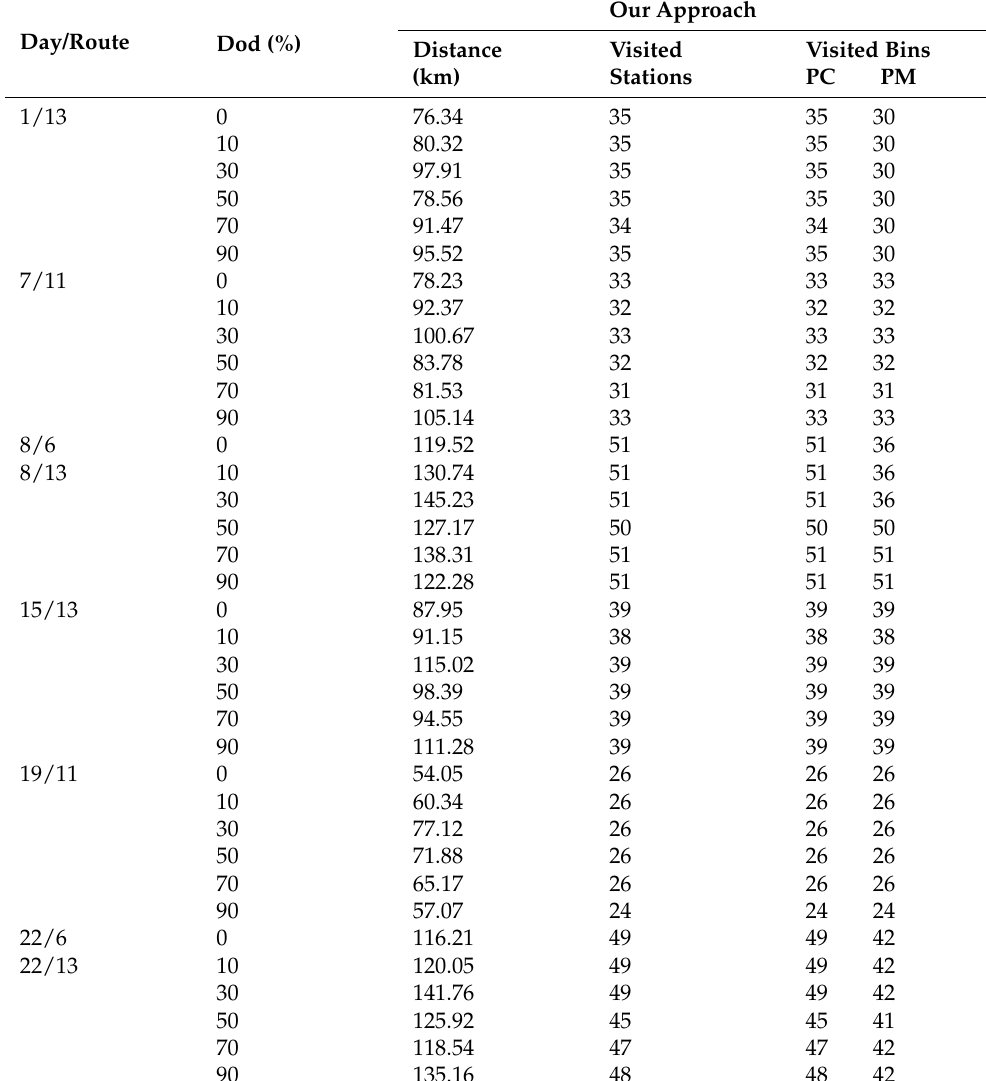
Table 11. Results for